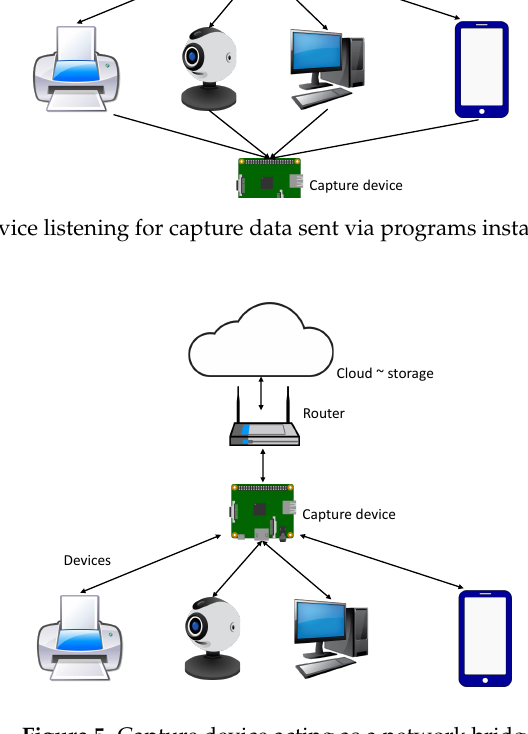
Figure 5. Capture device acting as a network